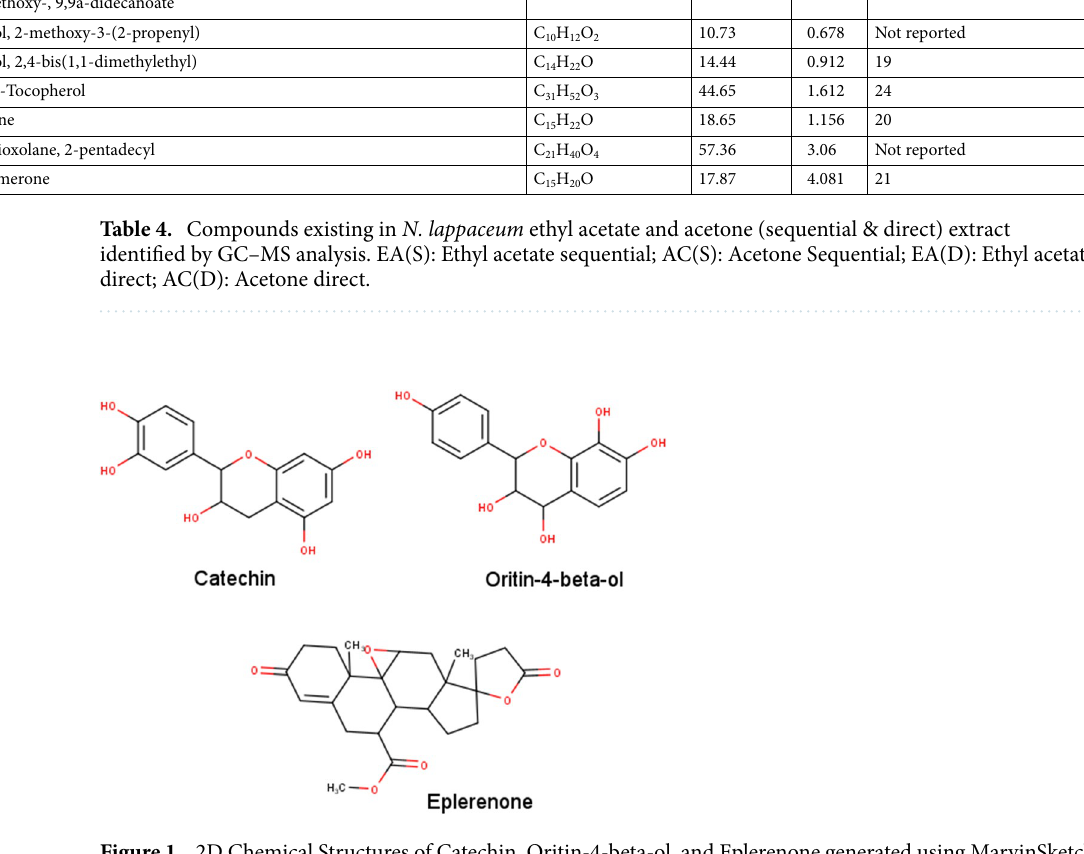
Figure 1. 2D Chemical Structures of Catechin, Oritin-4-beta-ol, and Eplerenone generated using MarvinSketch version 20.16 (http:// www. chema xon. com/) 31